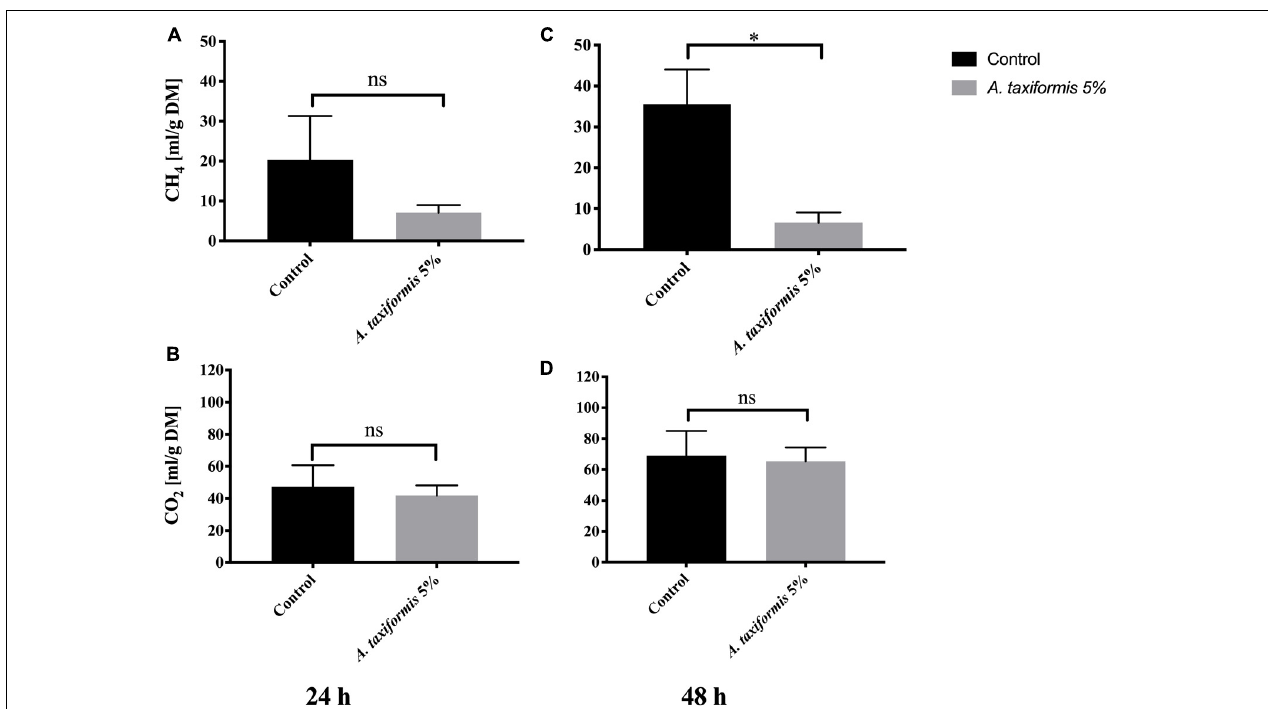
FIGURE 3 | Methane and CO 2 production during in vitro fermentation of rumen fluid amended with A. taxiformis . Production of CH 4 mL (g DM) − 1 and CO 2 mL (g DM) − 1 from vessels without ( n = 4) and with 5% ( n = 4) A. taxiformis as additive. Methane and CO 2 were measured at 24 h ( A,B , respectively) and 48 h ( C,D , respectively). “ ∗ ” indicates significant difference ( p -value < 0.05), “ns” indicates not significant. Error bars represent the standard error from the